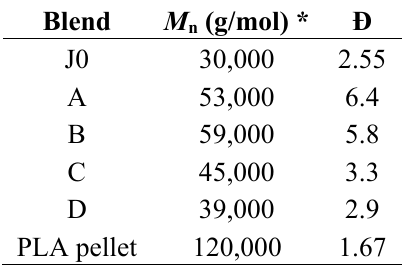
Table 5. Molecular weight and dispersity measured using GPC.